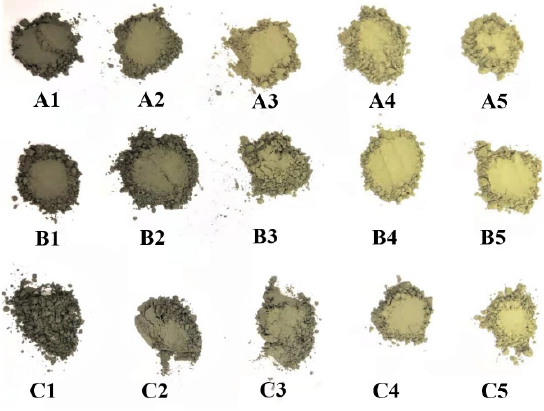
Figure 2. Samples (A1–A5, B1–B5 and C1–C5) after powdering.